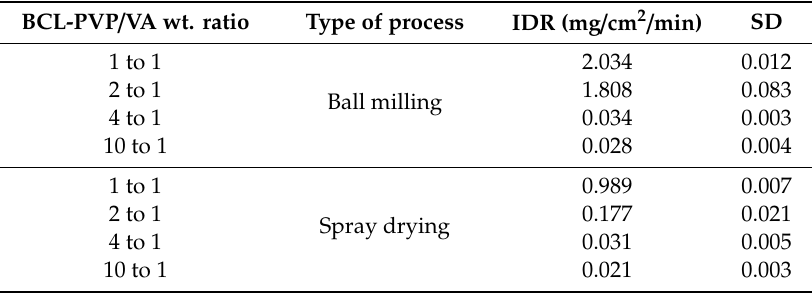
Table 4. The intrinsic dissolution rates obtained for prepared formulations.